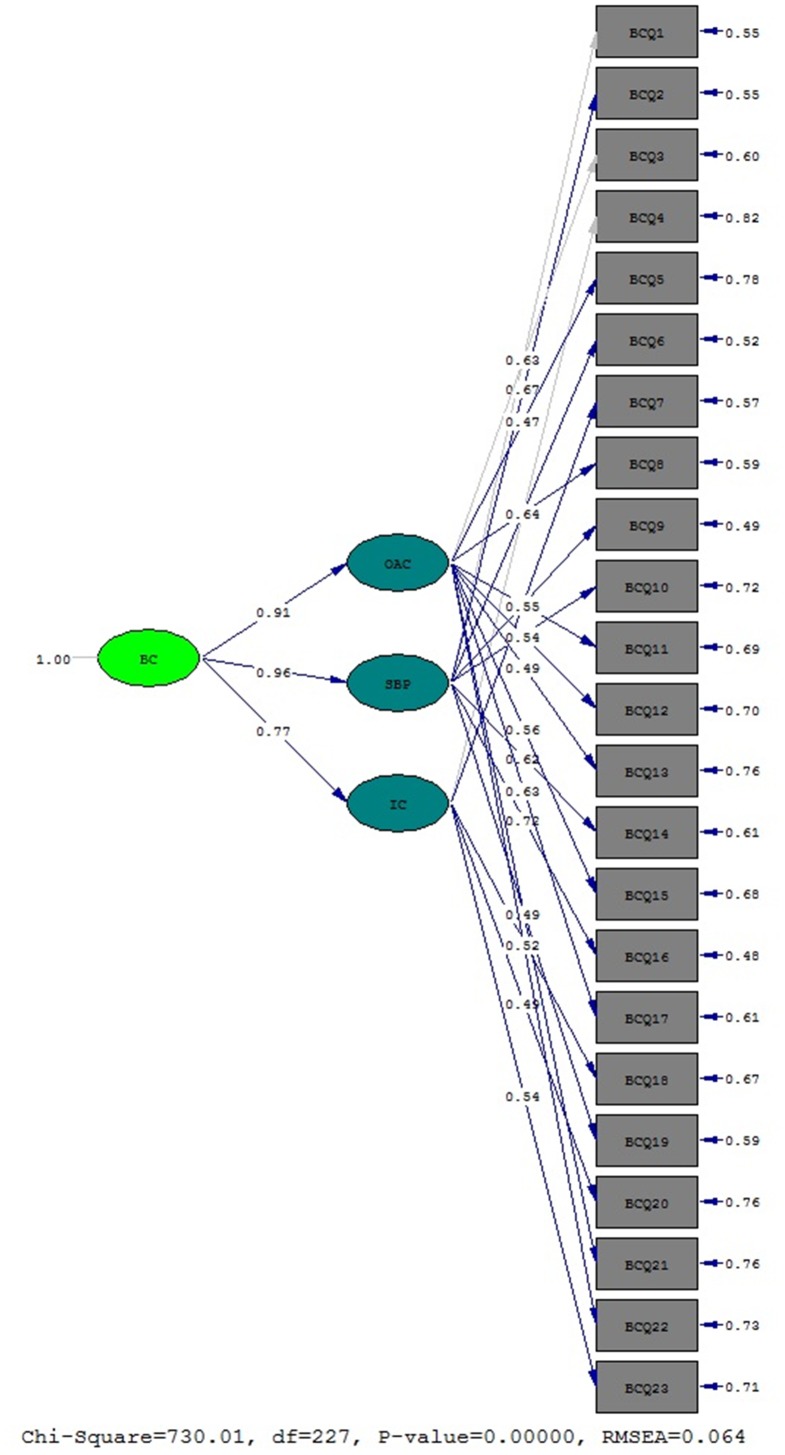
Adjusted model for Brazilian version of Body Checking Questionnaire.